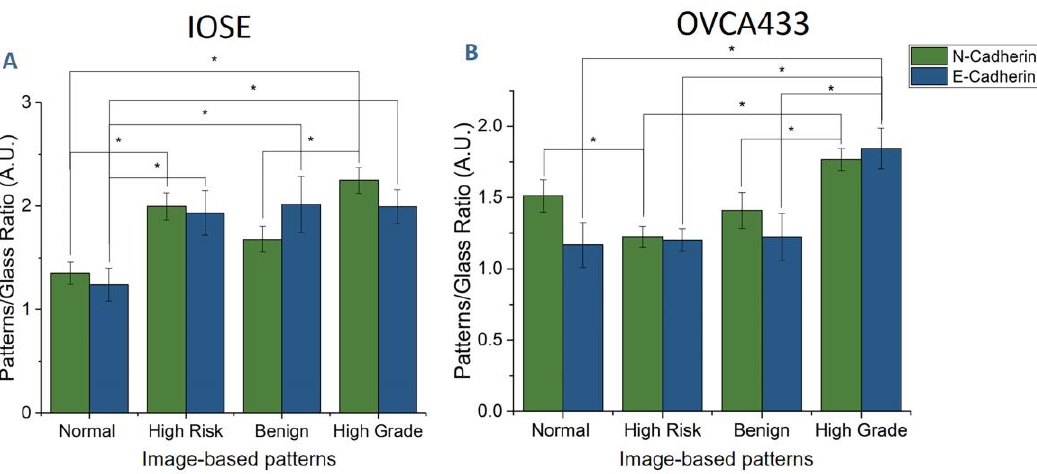
Figure 11. Immunofluorescence intensity ratio for cells on/off patterns of both E-cadherin and N-cadherin of IOSE ( A ) and OVCA433 ( B ) cells on image-based patterns (* p < 0.05).